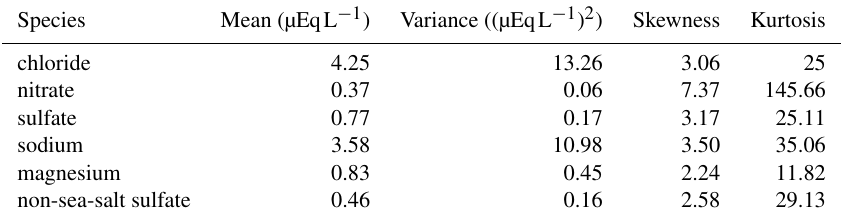
Table 4. Summary statistics for the level-1 trace ion chemistry data for each analysed species calculated over the full 2000 years of data included in this compilation.